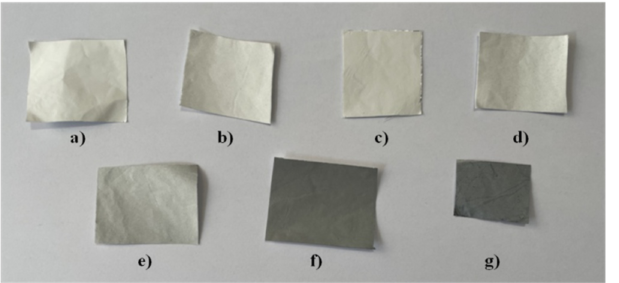
Figure 1. The electrospun PEO scaffolds with different concentrations of rGO: ( a ) PEO-neat, ( b ) PEO- rGO-0.1, ( c ) PEO-rGO-0.5, ( d ) PEO-rGO-1.0, ( e ) PEO-rGO-5.0, ( f ) PEO-rGO-10.0 and ( g )